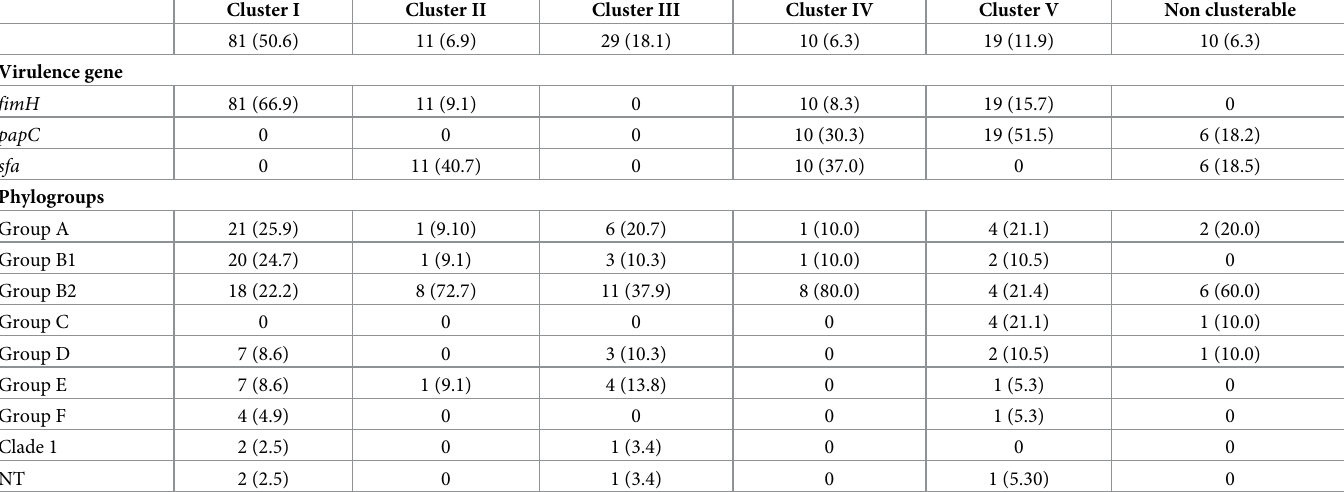
Table 8. Hierarchical clustering for distribution of adhesion virulence genes among E . coli isolated from ASB cases, total